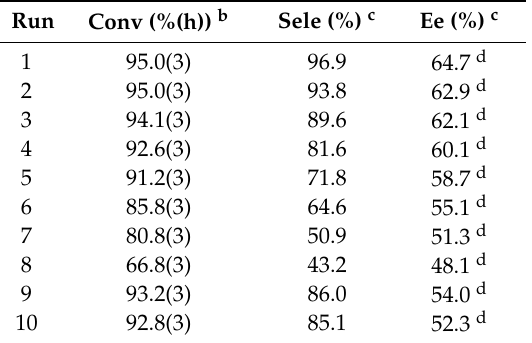
Table 5. The recycling of catalyst 3 in the asymmetric epoxidation of styrene with m -CPBA/NMO as oxidants a